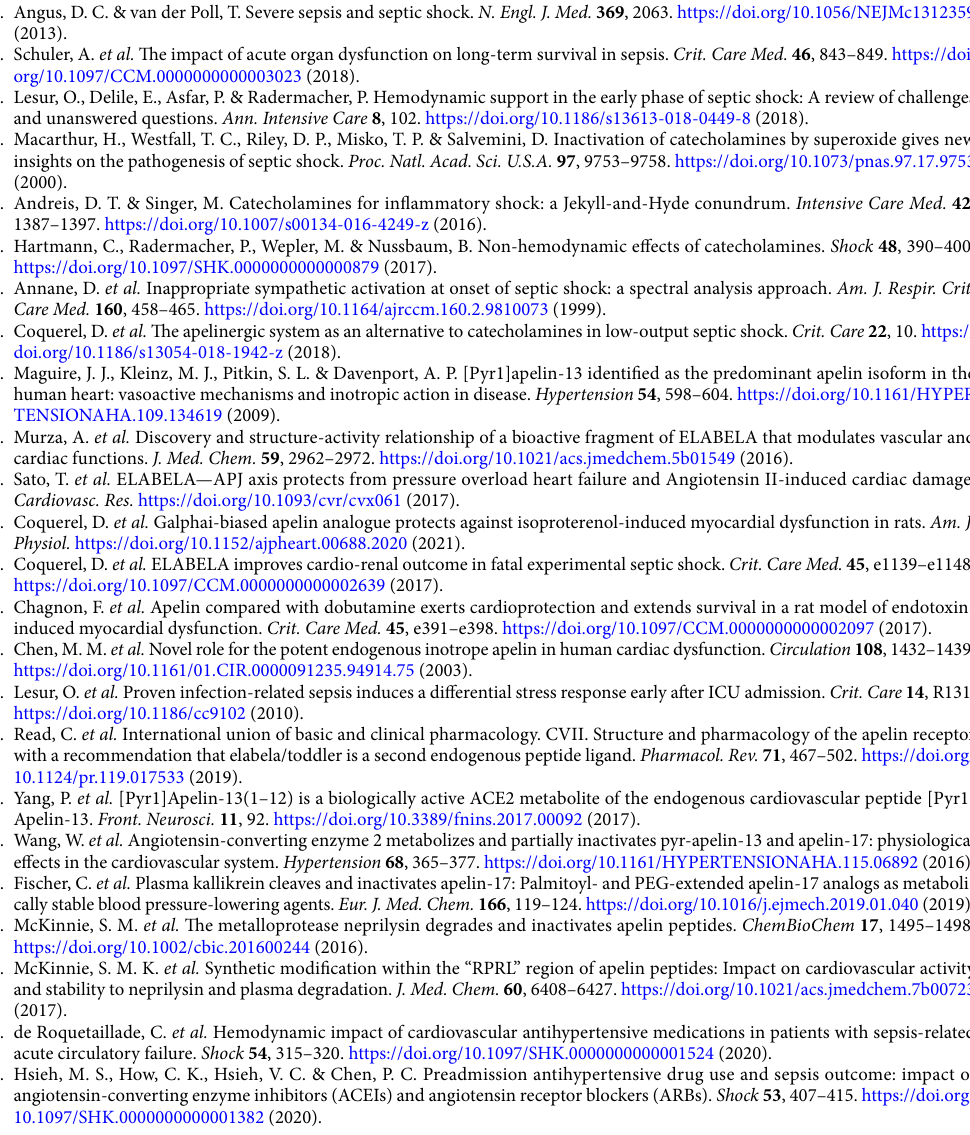
were expressed as a percentage of the initial zero-time spike area. Sample size calculation. Based on a pilot assessment of sheep with CO as the primary outcome, a difference of 1 L/min was considered “clinically significant”, with a targeted sample size of at least 6 animals/group to reach an α of 0.05 and a power of